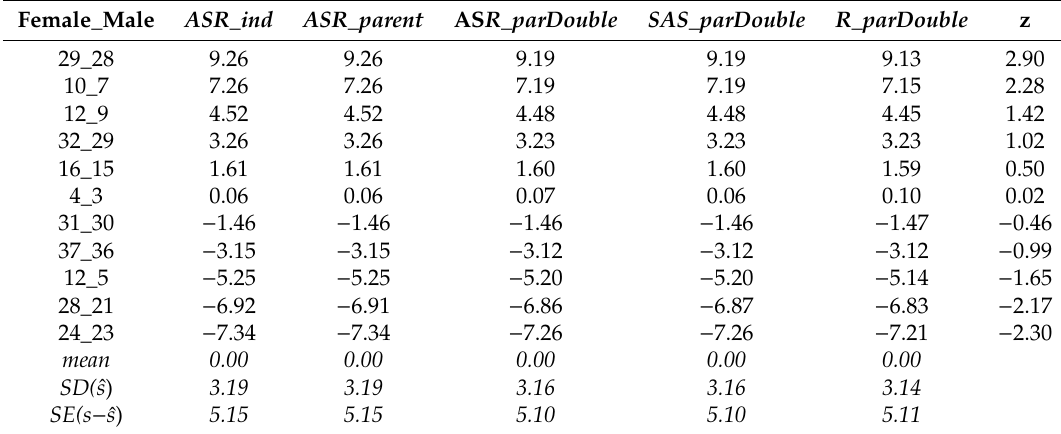
Table 5. Full-sib family Specific Combining Ability (SCA) predictions (ˆs) from five linear mixed models 1 for a simulated full-sib progeny dataset with 40 parents, 80 families from an unbalanced mating design, 4 tests, and 25 trees / family / test. SD(ˆs) = the observed standard deviation of the population of 80 SCA predictions. SE(a − â ) = the average standard error of prediction 2 . Selected full-sib families have SCA values that span the distribution of 80 families; standardized z-values are listed. 3 .